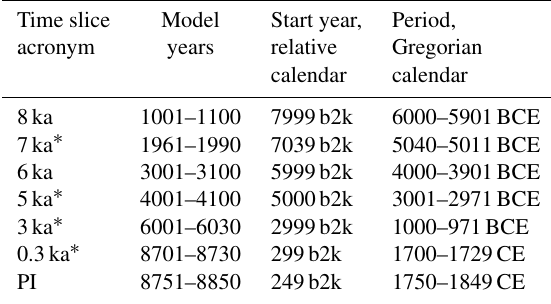
Table 1. List of time slices used in this study. For the time slices marked with ∗ , simulation has been restarted to produce daily output for 30 model years. Please notice that an interval of low variability had been chosen for these simulations; therefore, the time slice 7ka actually starts before 7ka (at model year 1961 instead of model year 2001). Please also notice that all means of theses time slices are based on 30years only, while the means on 8ka, 6ka, and PI are based on 100years. b2k is here defined by years before the year 2000CE. Time slice Model Start year, Period,